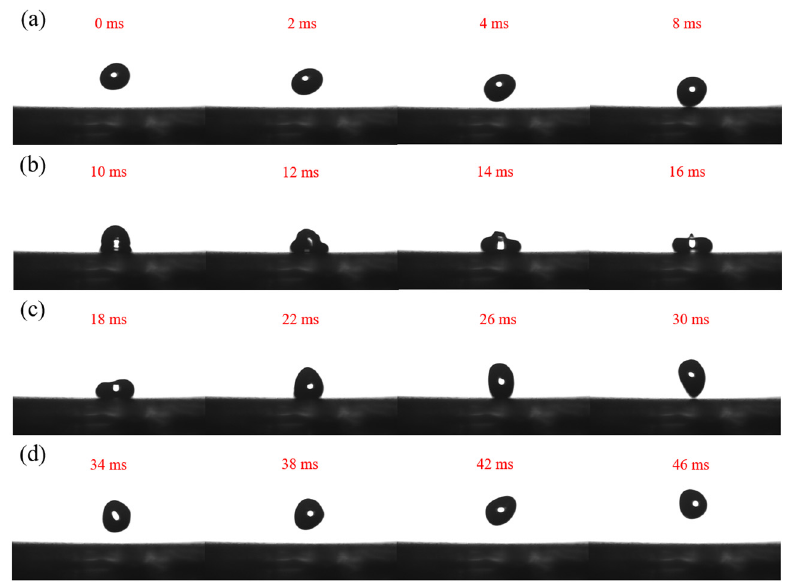
Figure 4. The WCA, EGCA, and WRA on ( a – c ) the stacked substrate and ( d – f ) the F 16 CuPc-modified biomimetic superhydrophobic surface. ( g ) The water column reflects images on the F 16 CuPc-modified biomimetic superhydrophobic surface. Images ( h ) before and ( i ) after the self-cleaning of the glass (left) and the F 16 CuPc-modified biomimetic superhydrophobic surface (right).